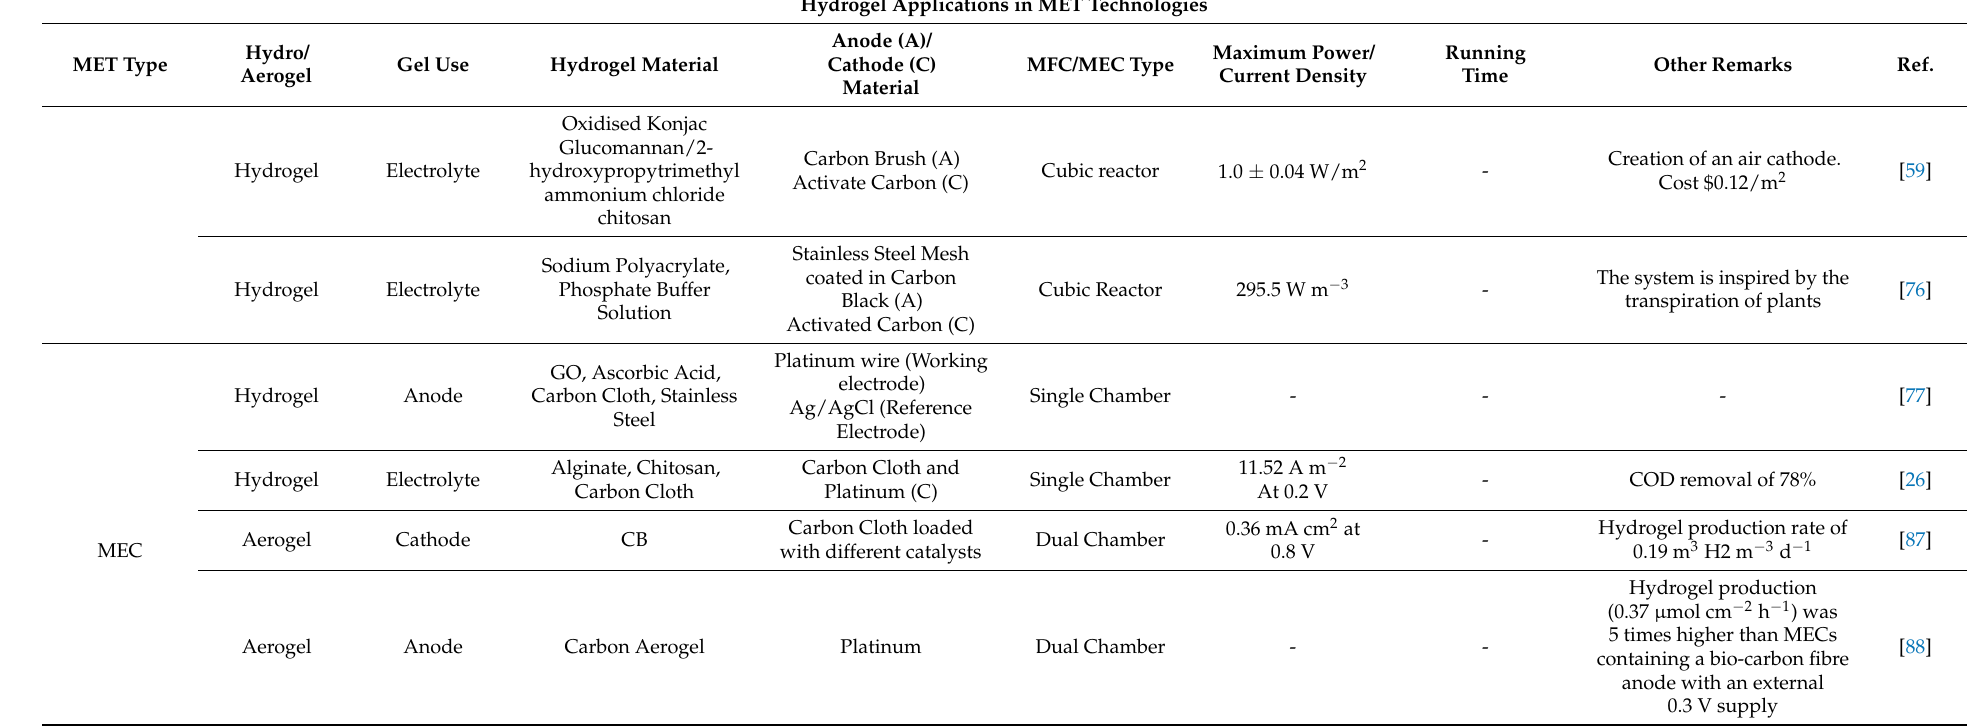
Hydrogel Applications in MET